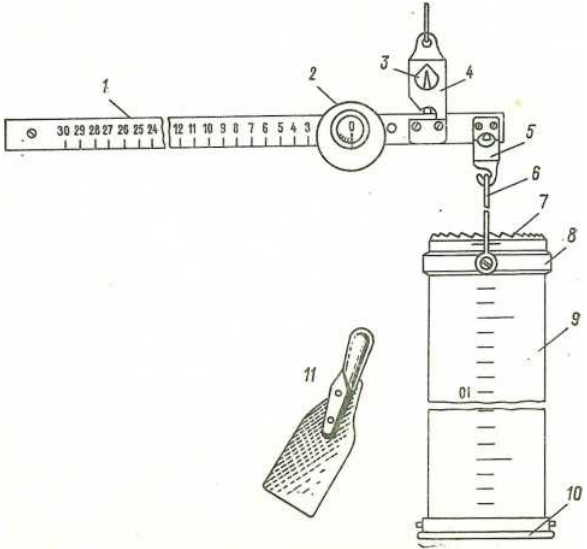
Figure A1. Assembly of the VS-43 snow tube with original mechanical scales and shovel. Scales: 1-metal ruler, 2-movable rider, 3-pointer, 4-suspension, 5-hook; Snow tube: 6-handle, 7-cutting end, 8-movable ring, 9-aluminum tube, 10-tube cover (cap), 11-a shovel. Source: [42,57]. Digital Kern HDB10K10N scales were used in the presented article instead of mechanical scales.